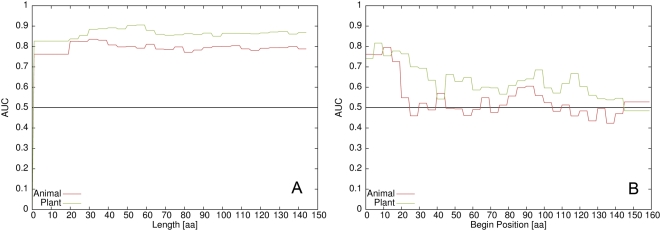
Exploration of position and length of the signal.Exploration of optimal length of the signal (A) and begin position of a 15 amino acid long window (B). The AUC value for each length and begin position is plotted for the animal pathogen set (red) and the plant symbiont set (green).